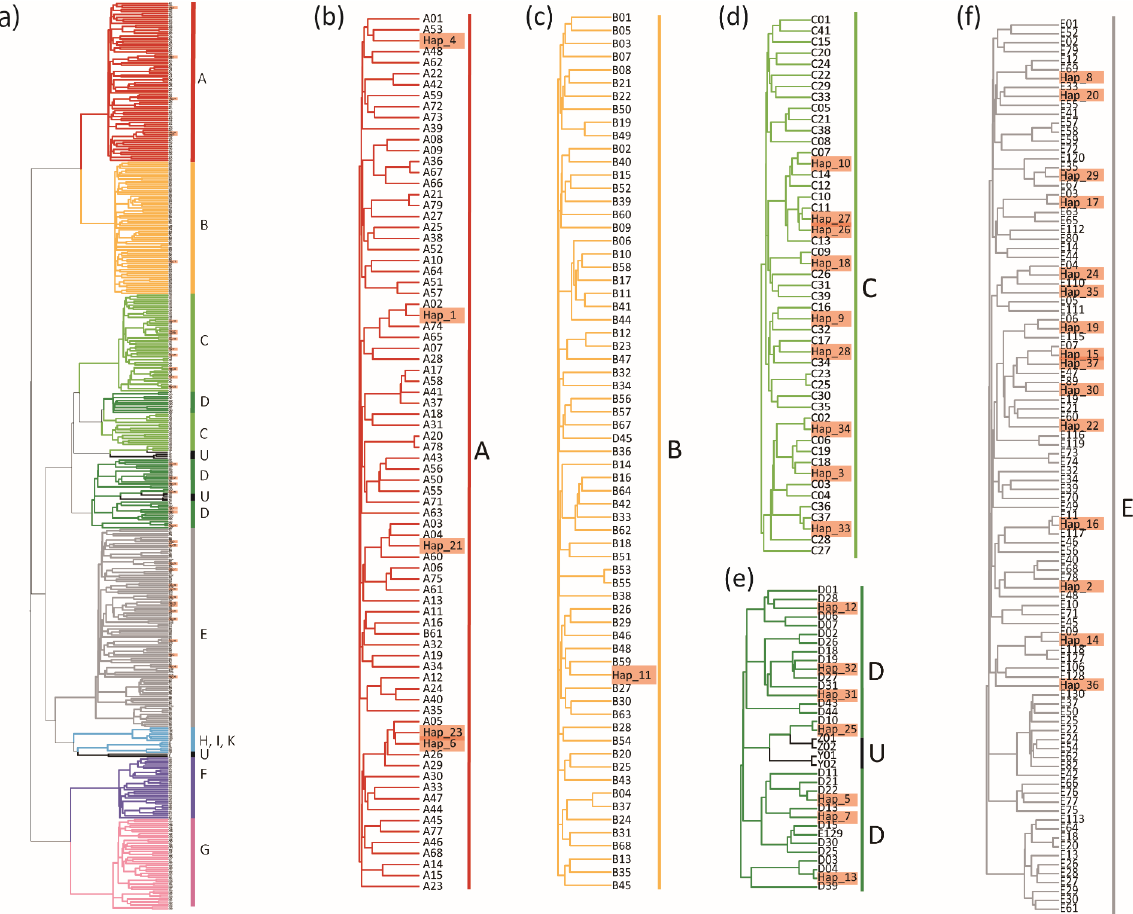
Figure 1. Bayesian phylogenetic tree of mitochondrial DNA D-loop haplotypes (Hap_1–Hap_37, highlighted with orange boxes) found in Japanese native chickens from 38 breeds, and in 57 individuals of four chicken breeds from foreign countries. The tree was constructed with 420 D-loop sequences (A01, A02, …Y, and Z), which were defined by Miao et al. (2013) (Table S5). Five clades which included the 37 haplotypes are highlighted with light blue boxes in the whole phylogenetic tree ( a ). Each of the five clades is shown in a separate figure ( b – f